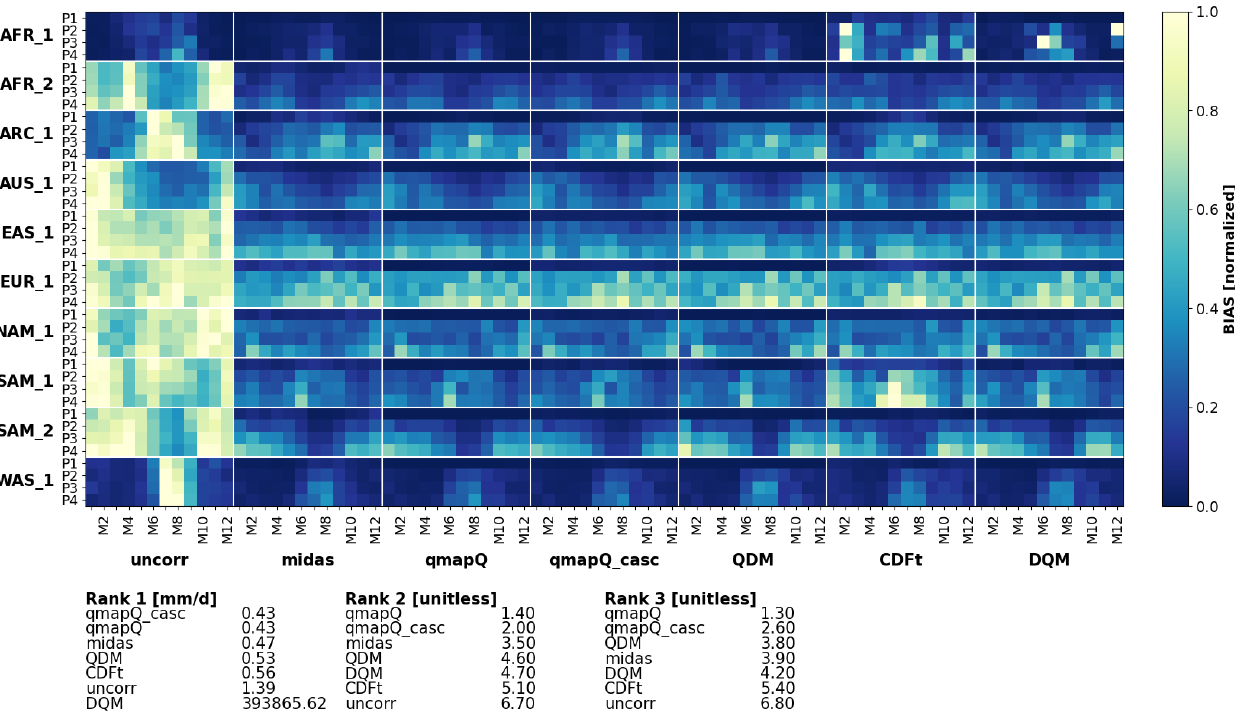
Figure 6. Bias of mean precipitation in the original data (uncorr) and after applying the different bias adjustment methods. P1–4 mark the evaluation periods 1971–2000 (also the calibration period), 2011–2040, 2041–2070, and 2071–2100. The results are presented for each of the domains (vertical) and for each month of the year (M1–12). The results are normalized for each sub-panel, i.e. each domain, such that the bias of the uncorrected data and all methods are in the range 0–1.